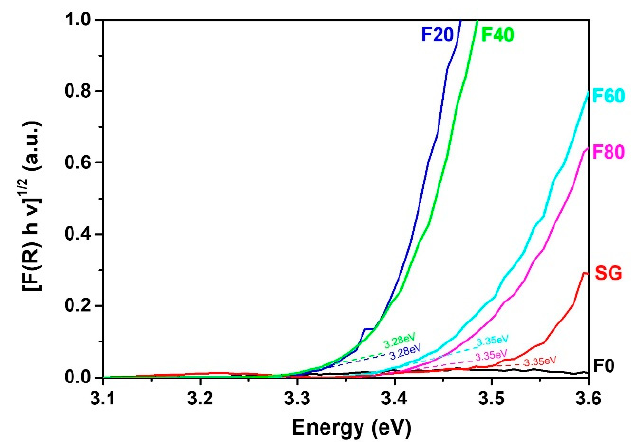
Figure 2. UV-visible DRS of the TiO 2 nanostructures.